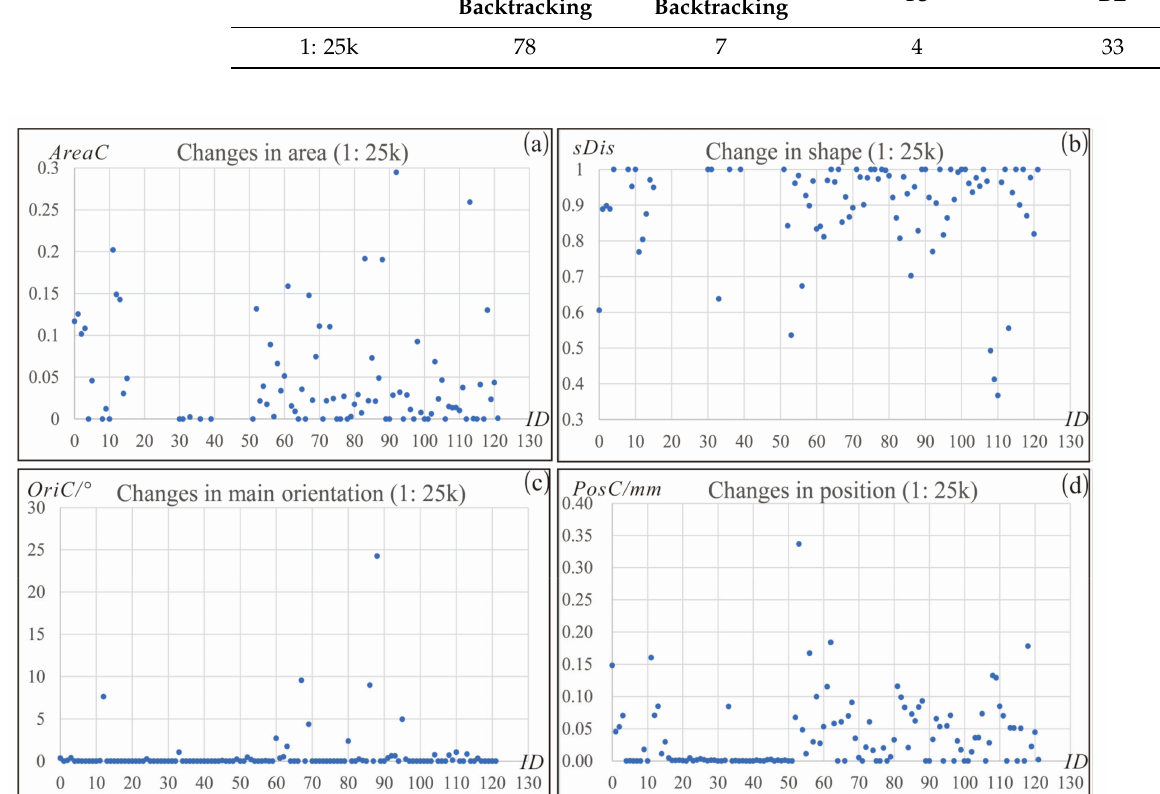
Figure 9. Comparison of changes in area ( a ), shape ( b ), main orientation ( c ) and position ( d ), shape between buildings at target and original